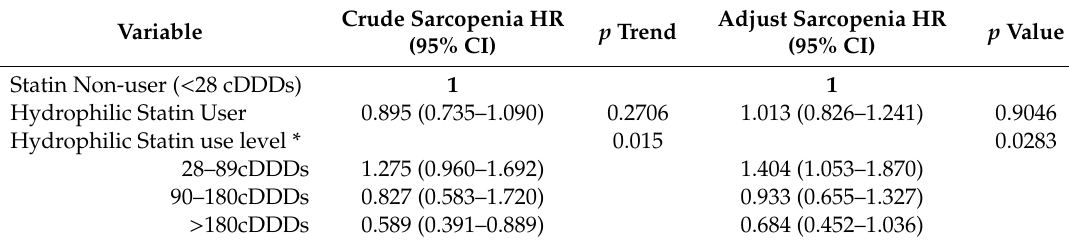
Figure 1. Cumulative incidence of sarcopenia by statins use among CKD patients in Taiwan during follow time. Table 5. Association between hydrophilic of statins and first-time sarcopenia among CKD patients in